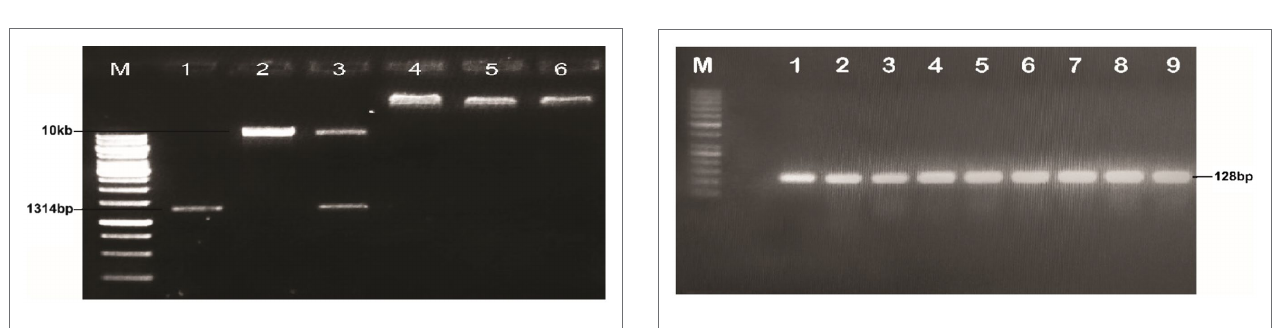
FIGURE 5 | Confirmation of the recombinant A. tumefaciens through PCR (Short length primers); Lane M: 1 kb molecular weight marker; Lanes 1–9: MBI7747 ( Gh_A07G1537 ).